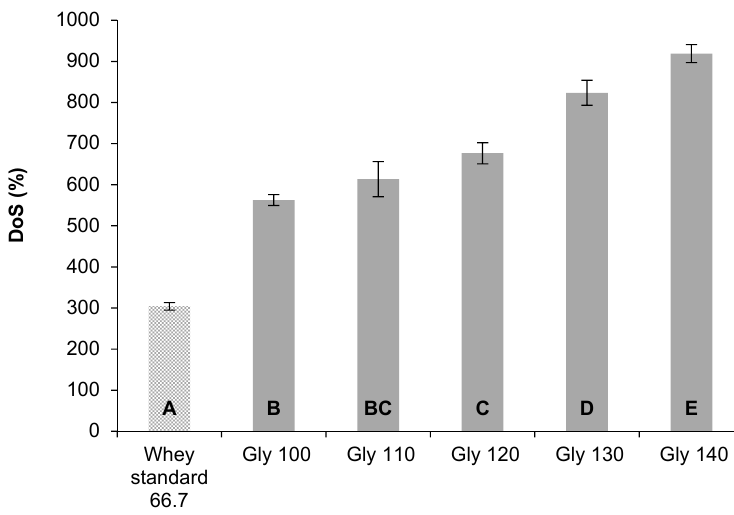
Figure 3. Influence of glycerol (Gly) concentration ( w / w protein) on the degree of swelling (DoS) of PPI-based cast films and the DoS of WPI-based cast film as a reference. Columns with different letters are significantly different ( p < 0.05). Error bars denote standard deviation.